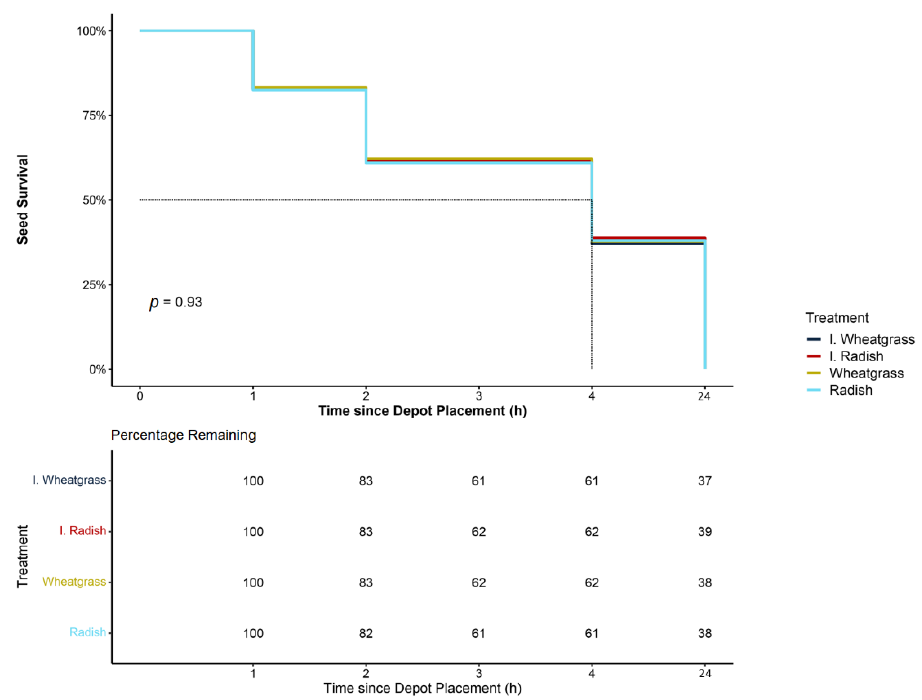
Figure 6. Kaplan–Meier curve of seed types’ likelihood of survival over the course of the seed inoculation trial based on selected data. ( n = 33 colonies). The dashed line indicates the overall median removal time. “I” indicates the inoculated seed treatments for each tested seed type. The mean percentage of remaining seeds per type at each time point is given in the table below, with colors matching each seed type’s Kaplan–Meier curves color.